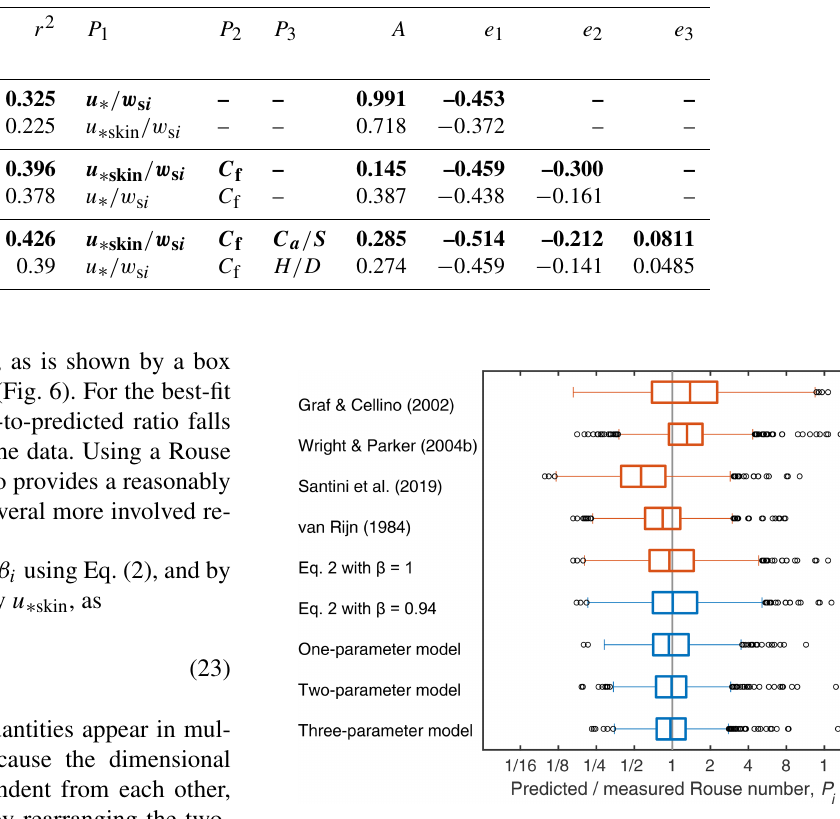
Figure 6. Box plot of predicted versus measured Rouse number, P i , for our models and previous models. The best-fit one-, two-, and three-parameter models correspond to the equations in bold